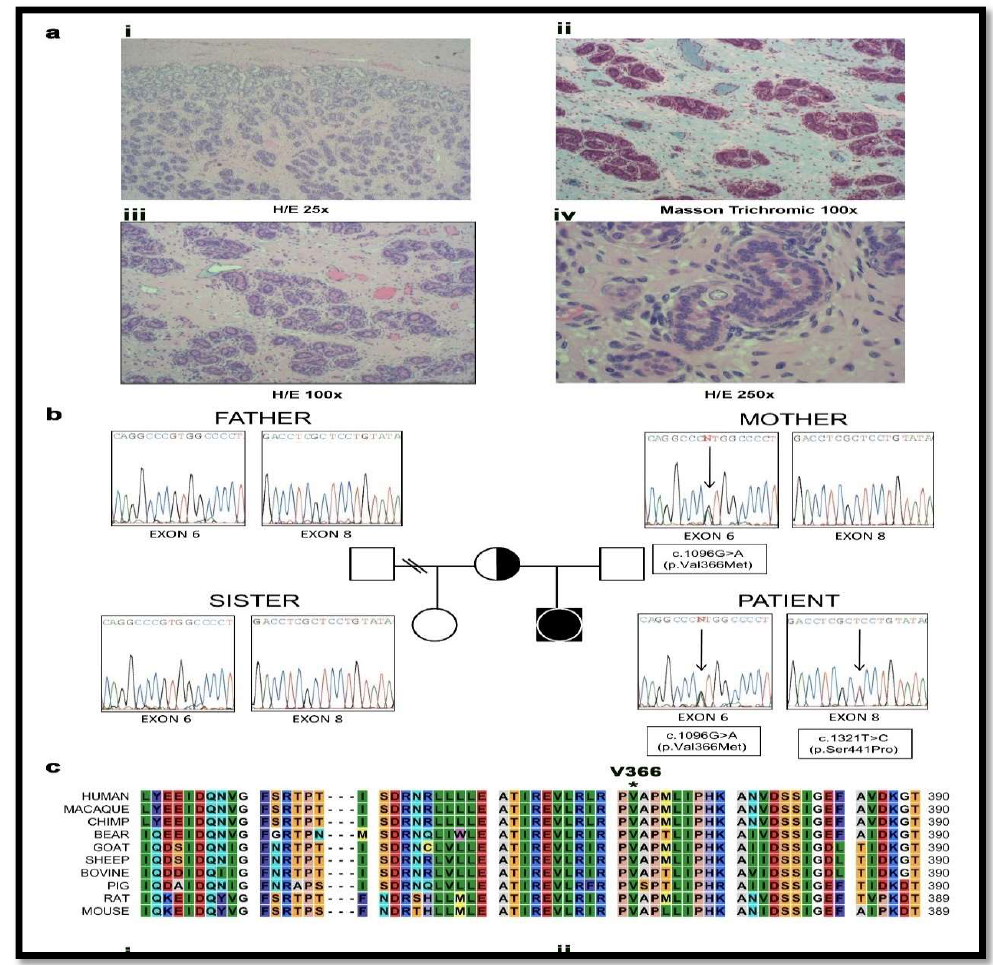
Figure 3. Genetic characterization and testis histology of the 46, XY disorder of sexual development (DSD) patient with a female phenotype. ( a ) Histopathologic studies revealed that both gonads consisted of atrophic and immature seminiferous tubules which were filled almost exclusively with pre-Sertoli cells. The fertility index was 5% with abortive and fetal type spermatogonia (i–iv); iii. in some areas, the tubules formed lobule-like structures similar to pseudo-hamartomas surrounded by collagen fibrous tissue; iv. nests of fibroblastic pre-Leydig cells were found in the interstitium. Albuginea and epidydimus were unremarkable. H/E-hematoxylin-eosin stain. ( b ) Family tree and electropherograms showing the index patient, the parents and the half-sister. Both, the patient and mother harbored the heterozygote c.1096G > A (p.Val366Met) mutation in exon 6, while the heterozygote c.1321T > C (p.Ser441Pro) mutation in exon 8 was only present in the patient. The father and the half-sister were both non-carriers of either mutation. ( c ) Alignment of human CYP17A1 amino acid sequence with a range of CYP17A1 proteins from other species found in the Universal Protein Knowledgebase (UniProt) database. The Valine 366 residue is highly conserved in all species studied .